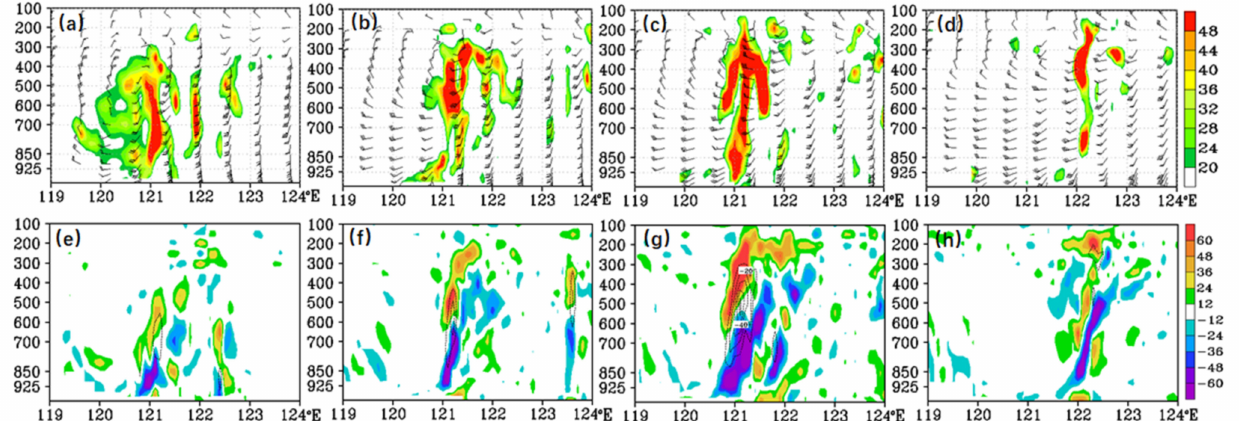
Figure 8. Simulated section of relative vorticity (shaded area, ≥ 20, unit: 10 − 5 s − 1 ) and wind (barbs, unit: m s − 1 ) ( a – d ), divergence (shaded area, unit: 10 − 5 s − 1 ) and vertical velocity (black line, ≤− 0.1, interval = 10, unit: Pa s − 1 ) ( e – h ) along the MCC center 30.5 ◦ N on 4–5 August 2020. ( a , e ) 20:00 BT 4, ( b , f ) 02:00 BT 5, ( c , g ) 04:00 BT 5, ( d , h ) 08:00 BT